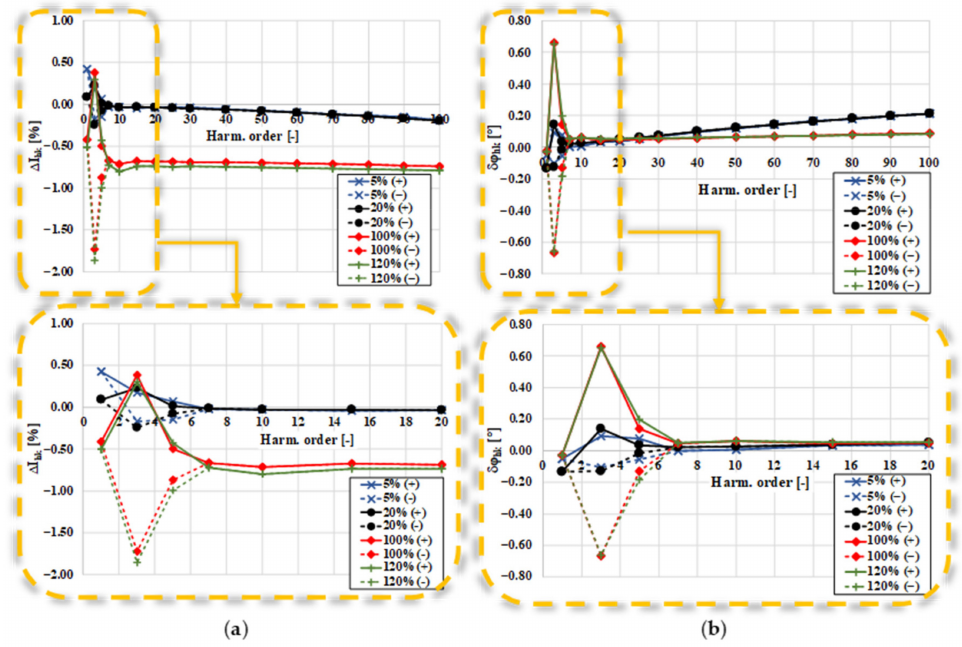
Figure 6. The frequency characteristics of the current error ( a ) and phase displacement values ( b ) of the tested ECT for the resistive load equal to 300 Ω .